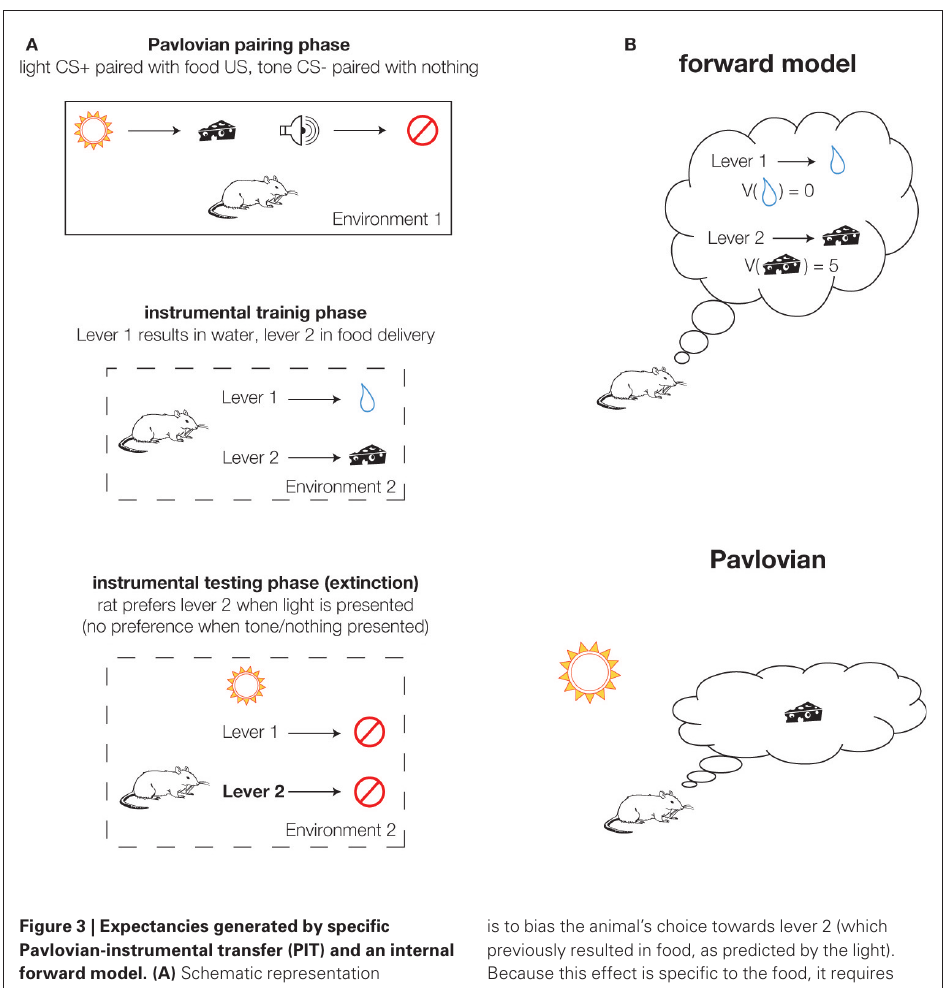
Figure 3 | Expectancies generated by specific Pavlovian-instrumental transfer (PIT) and an internal forward model. (A) Schematic representation of a canonical specific PIT experiment (after Kruse et al. 1983). The animal is exposed to Pavlovian pairing of a light (conditioned stimulus or CS + ) preceding food delivery (the unconditioned stimulus or US). Then, in a different environment, the animal learns to press lever 1 to obtain water and lever 2 to obtain food (the same food as in the pairing phase). Ideally these are calibrated such that the animal presses both equally. A specific PIT effect is obtained if, during the critical testing phase, the effect of presenting the light CS +